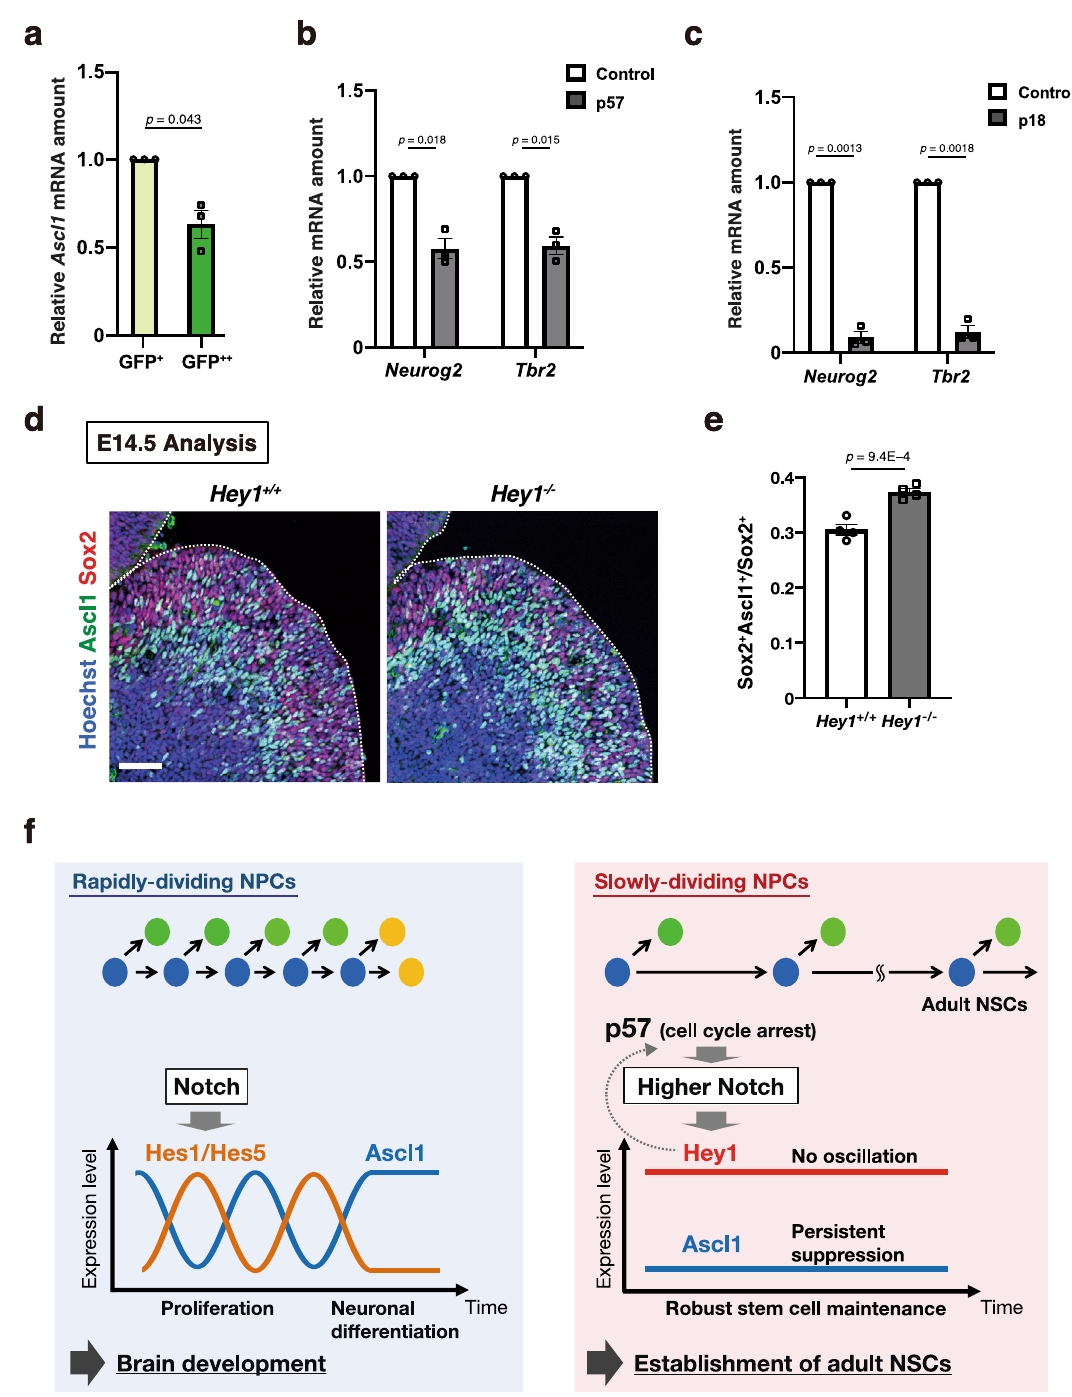
Fig. 7 Suppression of proneural gene expression in slowly dividing NPCs. a RT and real-time PCR analysis of Ascl1 mRNA in NPCs isolated from the LGE of Rosa-rtTA;TRE-mCMV-H2B-GFP embryos at E16.5 and sorted on the basis of H2B-GFP retention after exposure to 9TB-Dox at E9.5. Data were normalized by the amount of β -actin mRNA, are expressed relative to the corresponding value for GFP + cells, and are means± SEM ( n = 3 independent experiments), two-tailed paired t test. b , c RT and real-time PCR analysis of Neurog2 and Tbr2 mRNAs in cells positive for CD133 and GFP and negative for CD24 isolated by FACS from the neocortex of E17.5 embryos that had been subjected to in utero electroporation at E14.5 with plasmids for GFP alone (control) or together with p57 ( b ) or p18 ( c ). Data were normalized by the amount of β -actin mRNA, are expressed relative to the corresponding value for control, and are means± SEM ( n = 3 independent experiments), two-tailed paired t test. d Immunohistochemical analysis with antibodies to Ascl1 and to Sox2 for sections of the brain of control and Hey1 knockout mice at E14.5. Nuclei were stained with Hoechst 33342. Scale bar, 50 μ m. Dashed lines indicate the ventricular surface. e Quanti fi cation of the proportion of Ascl1 + cells among Sox2 + cells in the dLGE for sections as in d . Data are means ± SEM ( n = 4 embryos), two-tailed Student ’ s t test. f Model for the division of labor of Notch downstream effectors that can select the fate of “ rapidly dividing ” (oscillating Hes1/Hes5) versus “ slowly dividing ” (tonic Hey1) pools of embryonic NPCs, respectively.